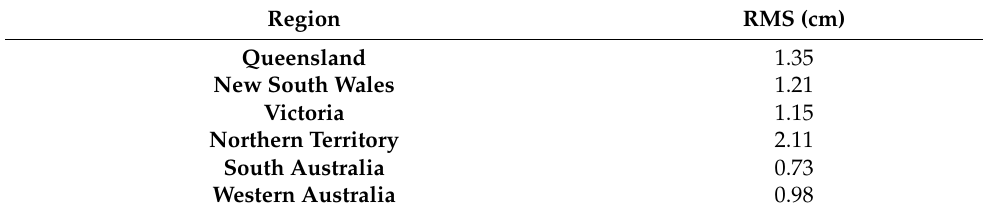
Figure 11. Spatial distributions of the RMS of residuals in TWSC determined after the removal of all trend and seasonal components. Table 6. RMS of TWSA for six